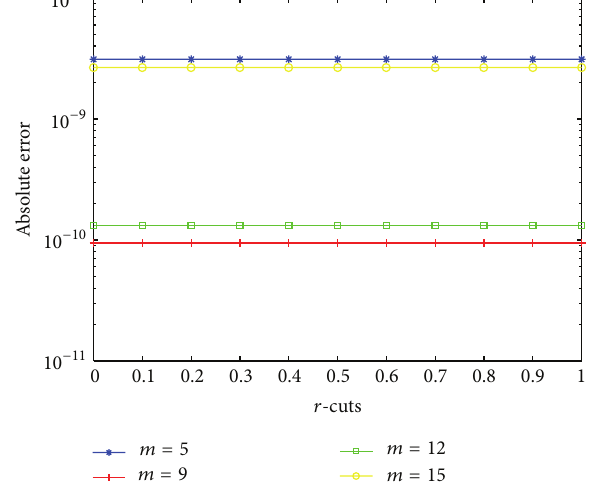
Figure 12: The absolute error for different values V = 𝛼 with 𝑚 = 6 , = 0.05 , and 𝑘 = 0.05 . 𝑘 1 2